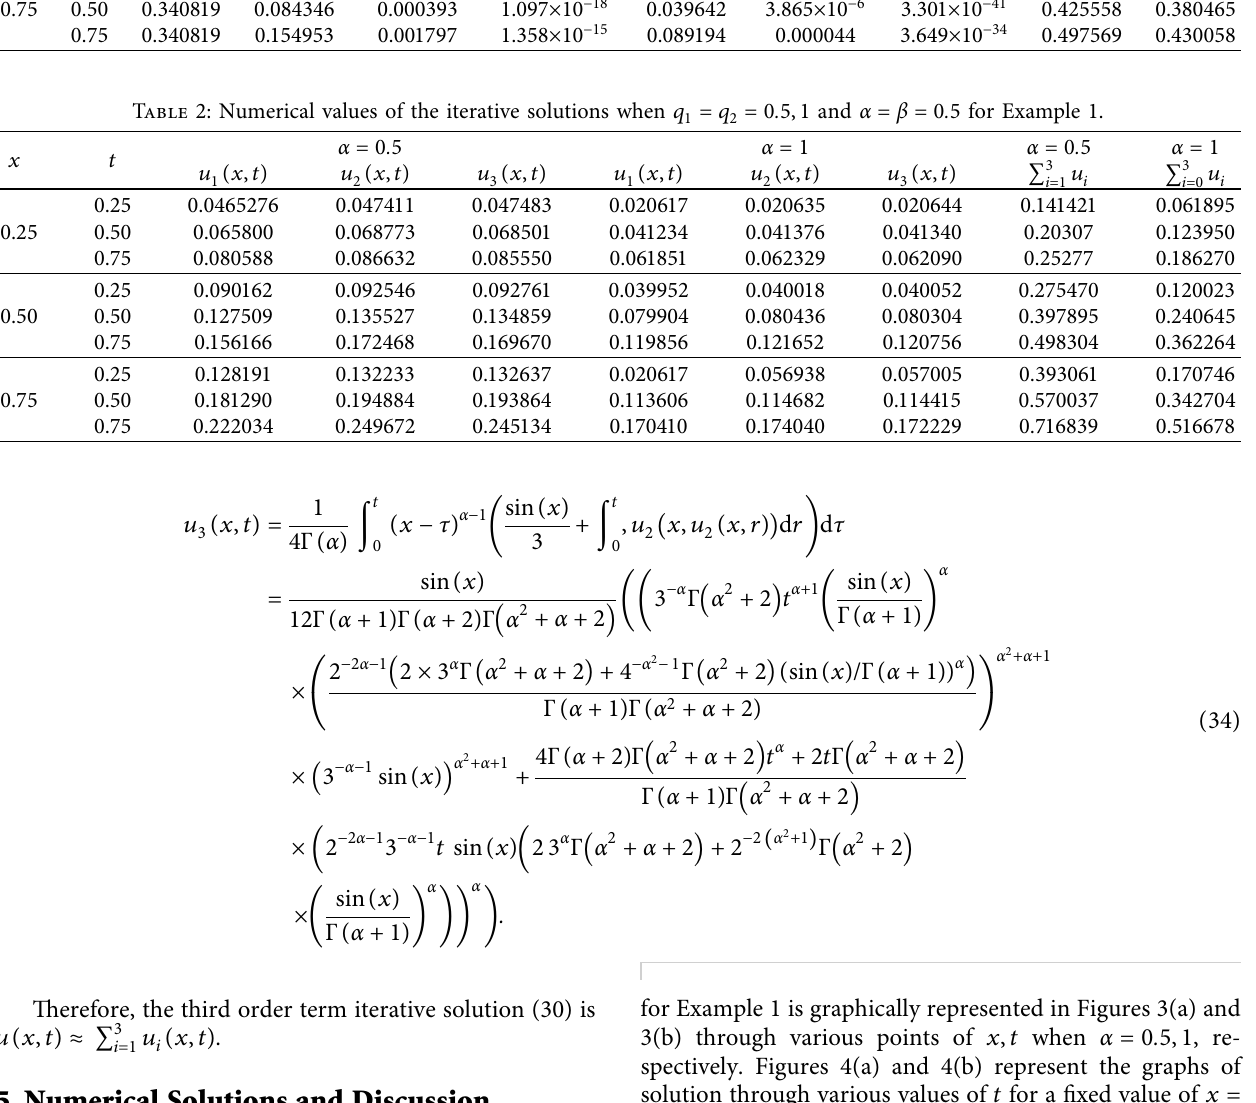
Table 1: Numerical values of the iterative solution when q